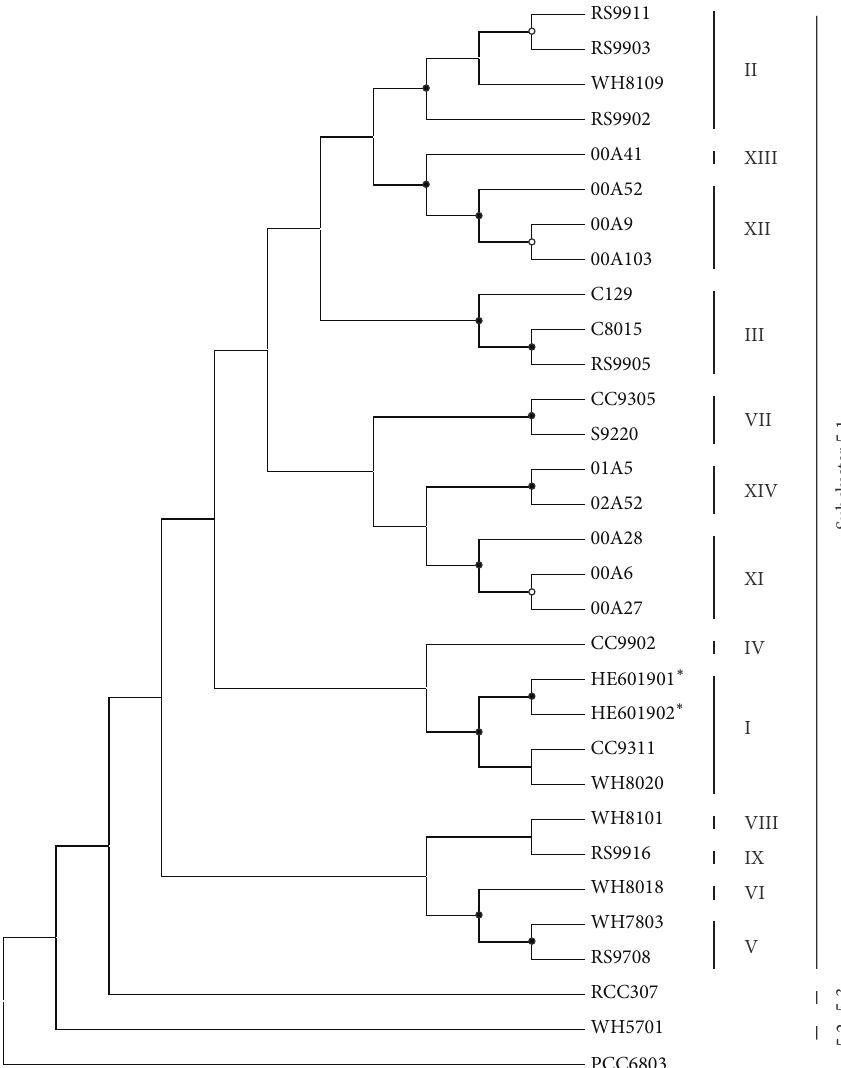
Figure 4: Neighbor-joining phylogenetic trees based on ntcA gene sequences. Bootstrap values were obtained through 1,000 repetitions. Similar tree topologies were observed by maximum parsimony analyses (not shown). ( ∙ ) indicates a value > 90% and ( ∘ ) indicates a value > 60%. The ntcA sequence from Synechocystis sp. PCC 6803 was used as outgroup. Synechococcus clades are marked with roman numbers. Sequences from the two Synechococcus isolates are indicated with an